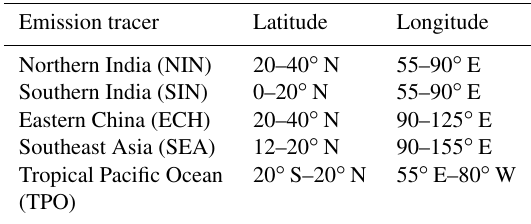
Table 1. Latitude and longitude range of artificial boundary layer sources in the CLaMS model, which are used to define the “Asian monsoon surface tracer”